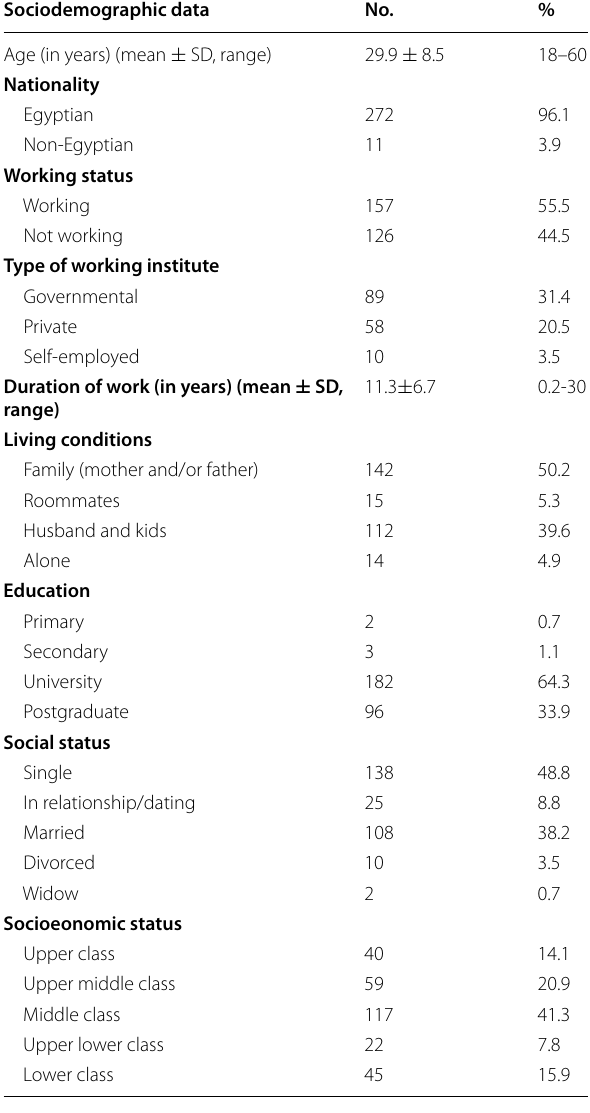
Table 1 Sociodemographic data of the harassed study participants ( n =